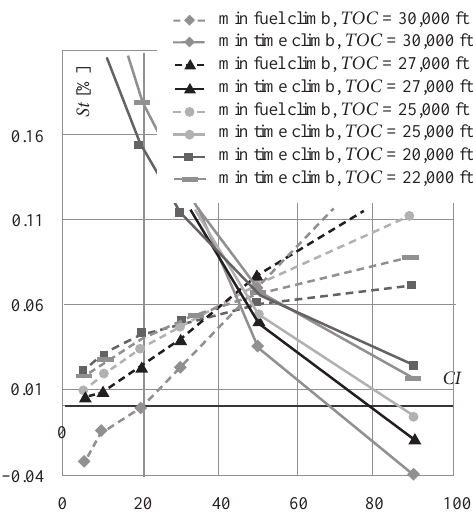
Fig. 7. Determination of the range of use of minimum costs climb technique, m c 1 = 51,000 kg